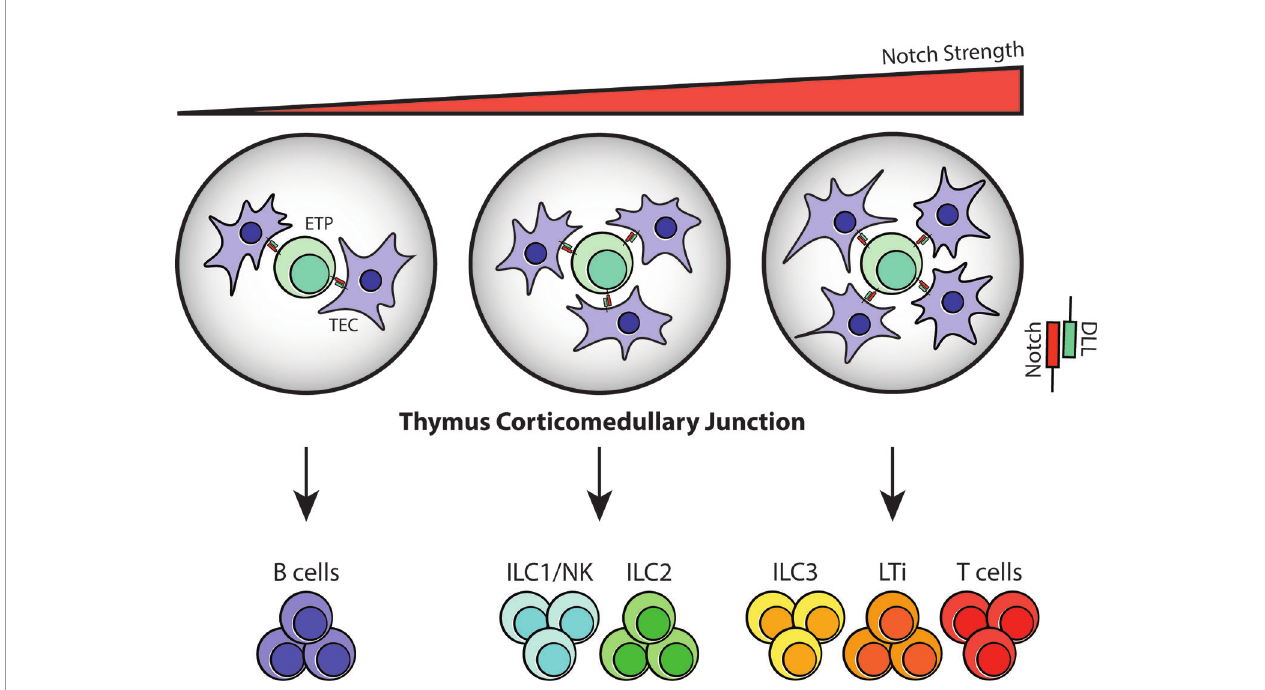
FIGURE 3 | Notch signaling at the thymus corticomedullary junction may determine T-cell/ILC fate. Notch signaling is mediated through direct cell-cell contact in the thymus; therefore, the number of TECs interacting with TSPs/ETPs at the corticomedullary junction will vary depending on cell position and niche availability. Based on the observations from in vitro assays, it is highly likely that ETPs that receive zero to low Notch-DLL interaction will differentiate into B cells. In contrast, strong Notch signaling will guide ETPs towards the T-cell and ILC3/LTi lineages while intermediate Notch signaling will result in ILC1/NK and ILC2 commitment during fetal and postnatal